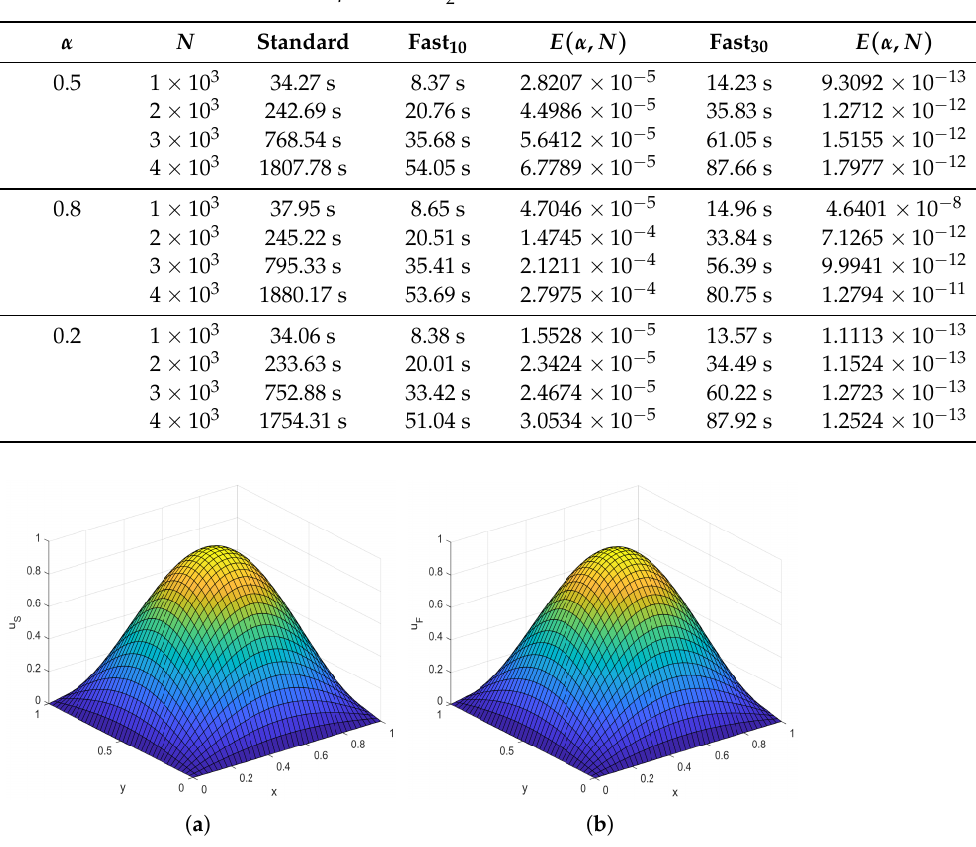
Table 5. Pointwise error with α = β and θ = α